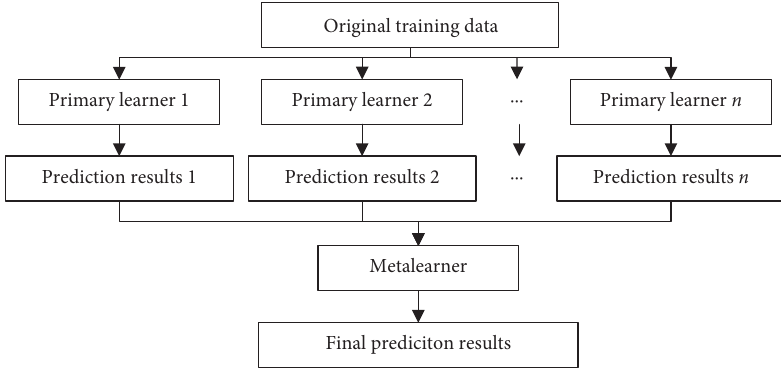
Figure 1: Stacking